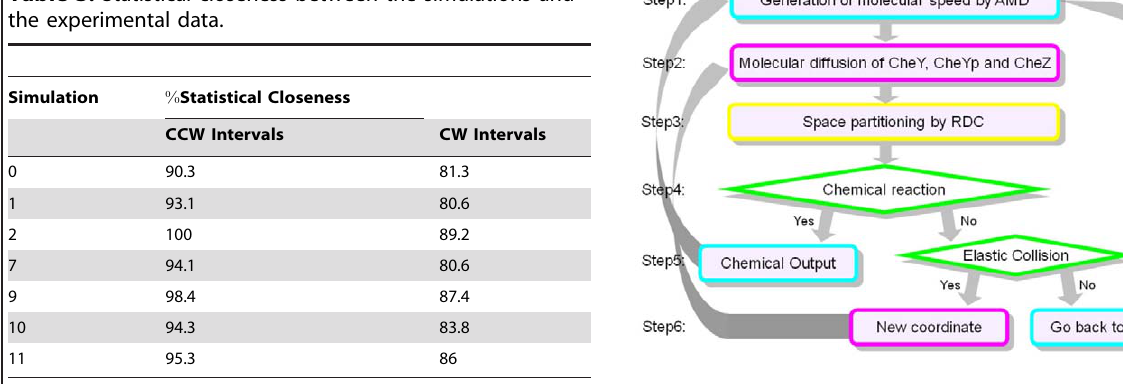
Figure 6. An outline of the MESMAX algorithm.